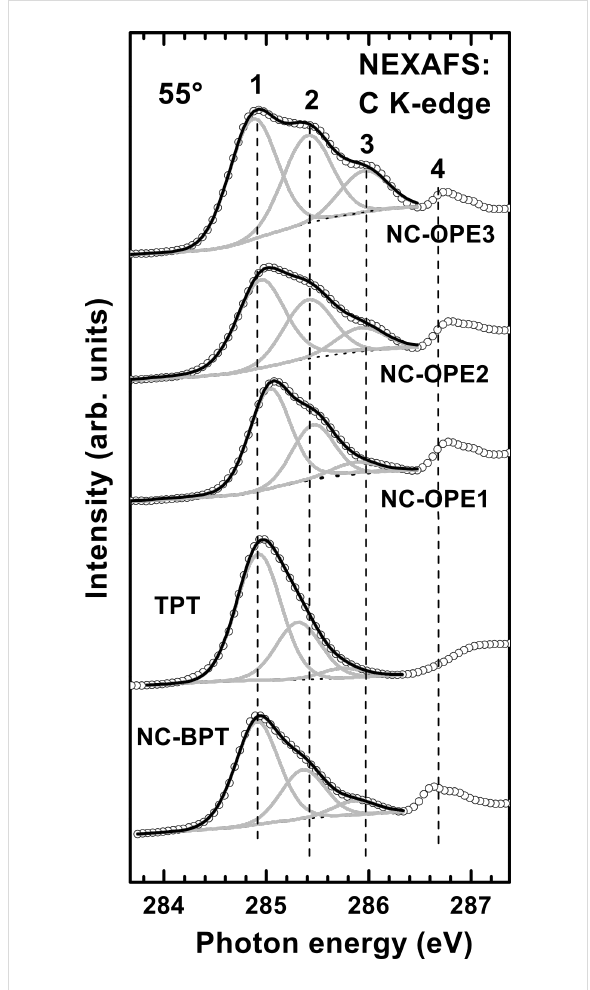
Figure 4: π *-resonance photon-energy range of the C K-edge NEXAFS spectra of the target SAMs and two reference films, NC-BPT/Au and TPT/Au. The spectra are decomposed into the indi- vidual contributions, which are marked by numbers; see text for